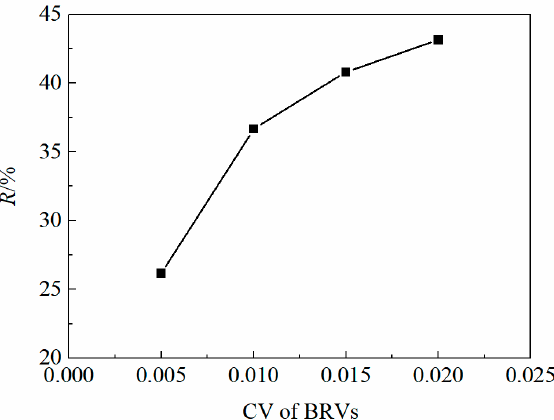
Figure 11. The correlation curve between the R of Composition B and the CV of the BRVs under the shock load condition where v is 1000 m/s.